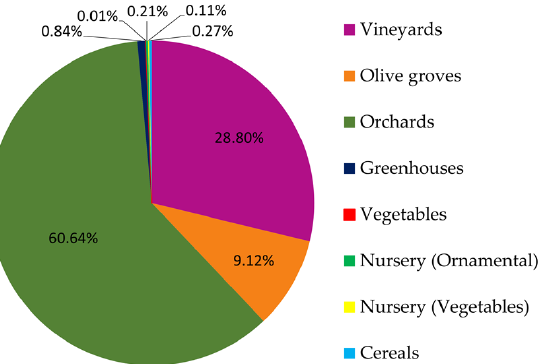
Figure 3. Distribution (%) of annual APW generated by the different crops in the four municipali- ties.